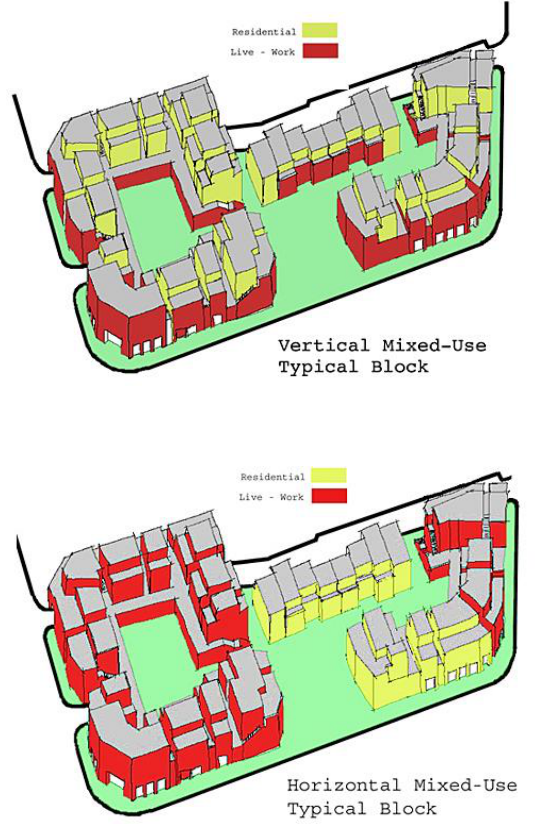
Figure 3. Vertical and Horizontal mixed-use